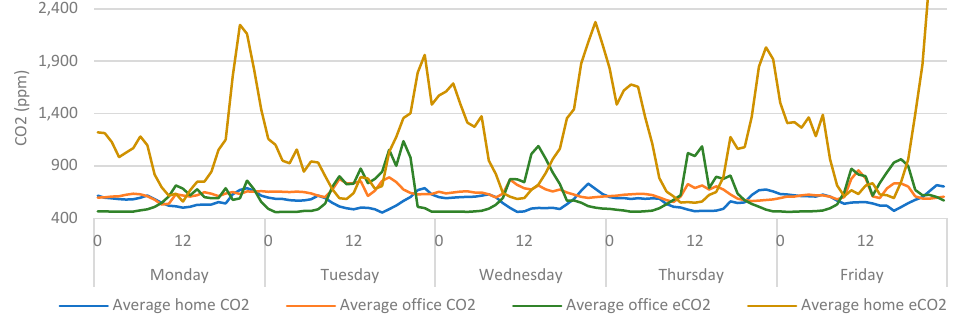
Figure 14. Average home/office CO 2 vs eCO 2 categorised by day > hour.